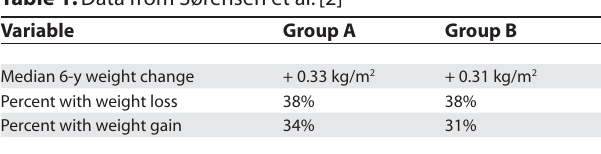
Table 1. Data from Sørensen et al. [2] Variable Group A Group B Median 6-y weight change + 0.33 kg/m 2 Percent with weight